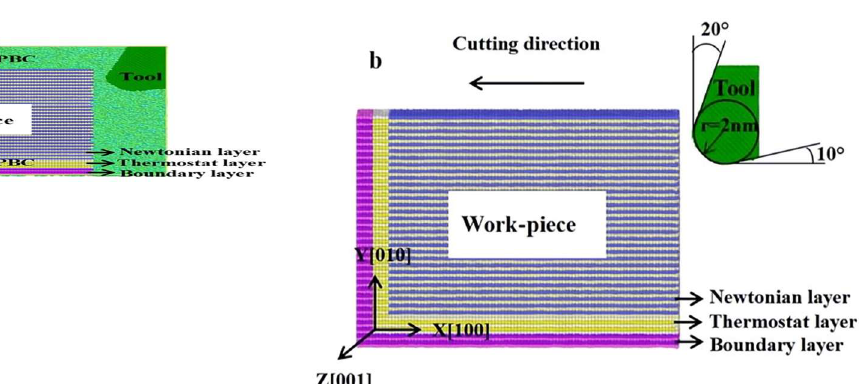
Figure 1. MD simulation model of single crystal γ -TiAl alloy (( a ), with water medium ( b ), without water